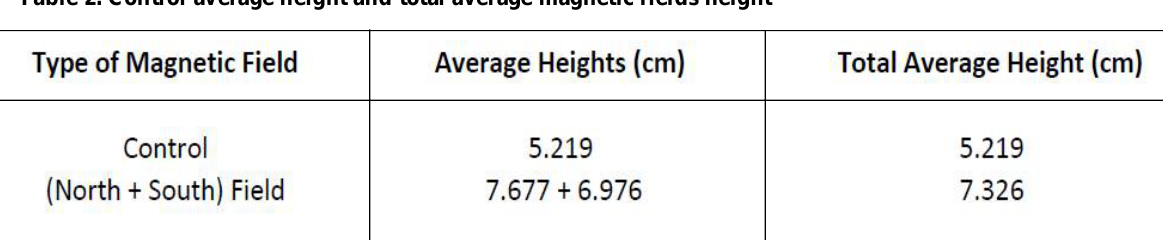
Table 2: Control average height and total average magnetic fields